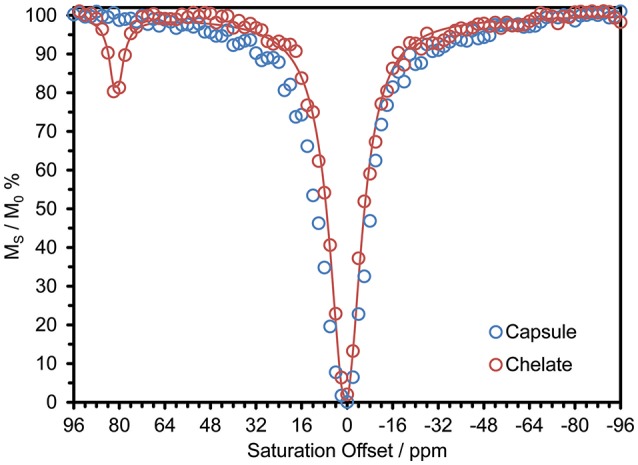
CEST spectra of 40 mM solution of DyDOTAM3+ at pH 6.5 and 298 K in 10 M CsCl, as discrete chelates (red, the line is a fit to the data using a 2-site exchange model of the Bloch equations Zhang et al., 2003. Fitting parameters are: τNH = 1.51 ms, T1NH = 6 ms, T1W = 2.3 s, T2NH = 5 ms, T2W = 0.31 s) and incorporated into RACs (blue) – CW irr. time = 10 s, B0 = 400 MHz, γB1 = 1000 Hz.